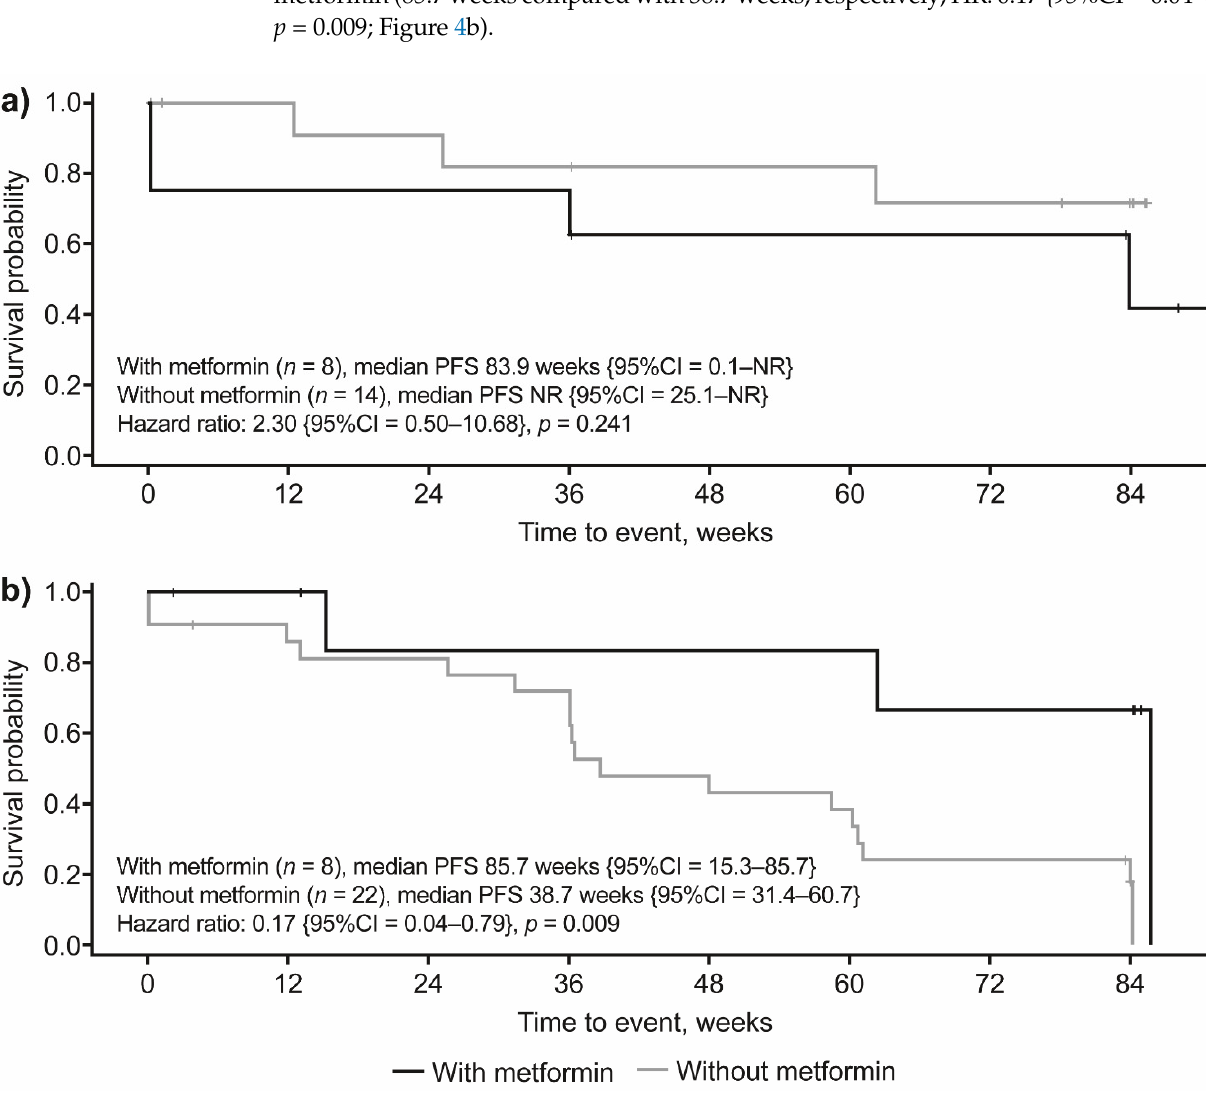
Figure 4. PFS by metformin treatment in patients with DM who developed DM prior to study treatment in patients receiving ( a ) lanreotide 120 mg and ( b ) placebo (additional analysis). The additional analysis included patients without disease progression at three months after treatment initiation. Based on this criterion, four patients were excluded from this analysis (lanreotide group, n = 3; placebo group, n = 1). CI, confidence interval; DM, diabetes mellitus; NR, not reached; PFS, progression-free survival.